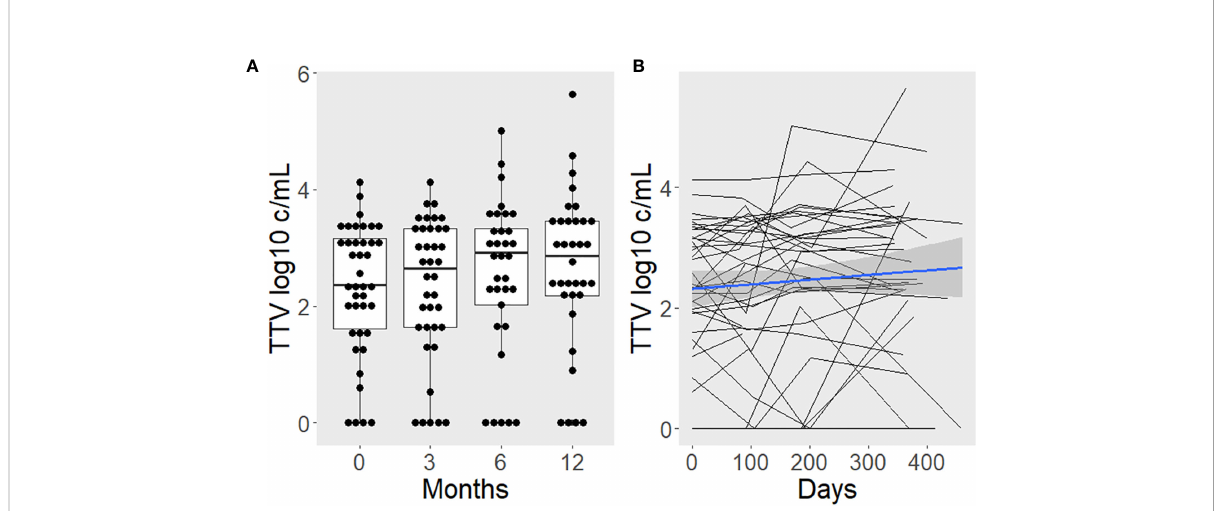
FIGURE 3 TTV load increases after surgery-induced weight loss. Boxplots with superimposed individual values are used to present the time course categorized by study visits (A) . Additionally, lines were drawn to depict intra-individual changes (B) . The blue line represents the average slope and intercept, with a gray band indicating the 95% con fi dence interval.